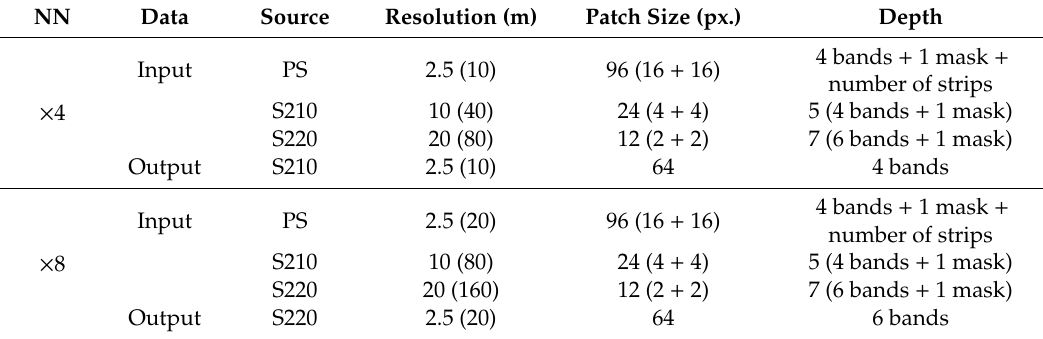
Table 2. Spatial resolution, patch size, and depth (number of channels) of input and output data for training and prediction of the two super-resolution neural networks (NNs): from 10 to 2.5 m ( × 4) and from 20 to 2.5 m ( × 8). PS, PlanetScope data; S210, Sentinel-2 10-m data; S220, Sentinel-2 20-m data. For resolutions, values not in brackets correspond to NN prediction. For patch sizes, values in brackets correspond to the overlapping pixels (both